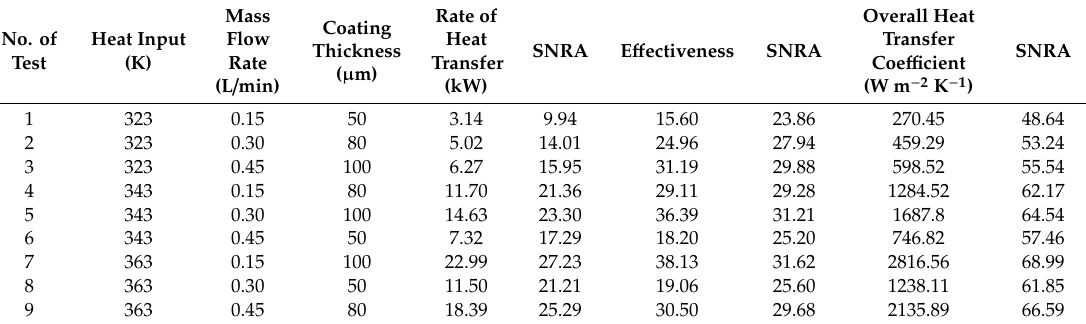
Table 6. Experimental Design for L 9 Orthogonal Array.